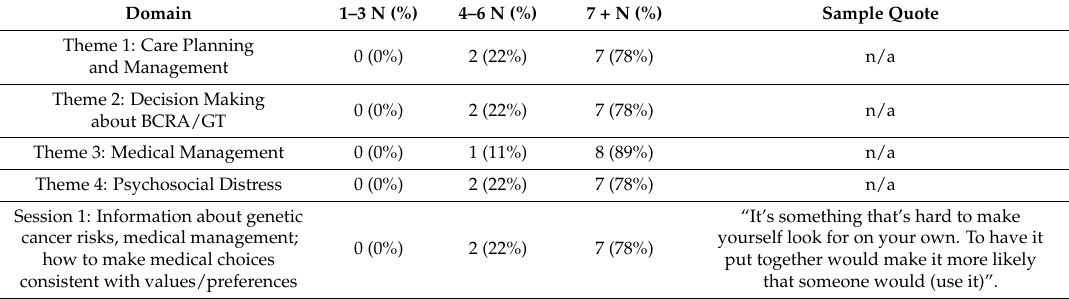
Table 4. Frequency of Acceptability of Intervention Content, Structure and Modality (N =